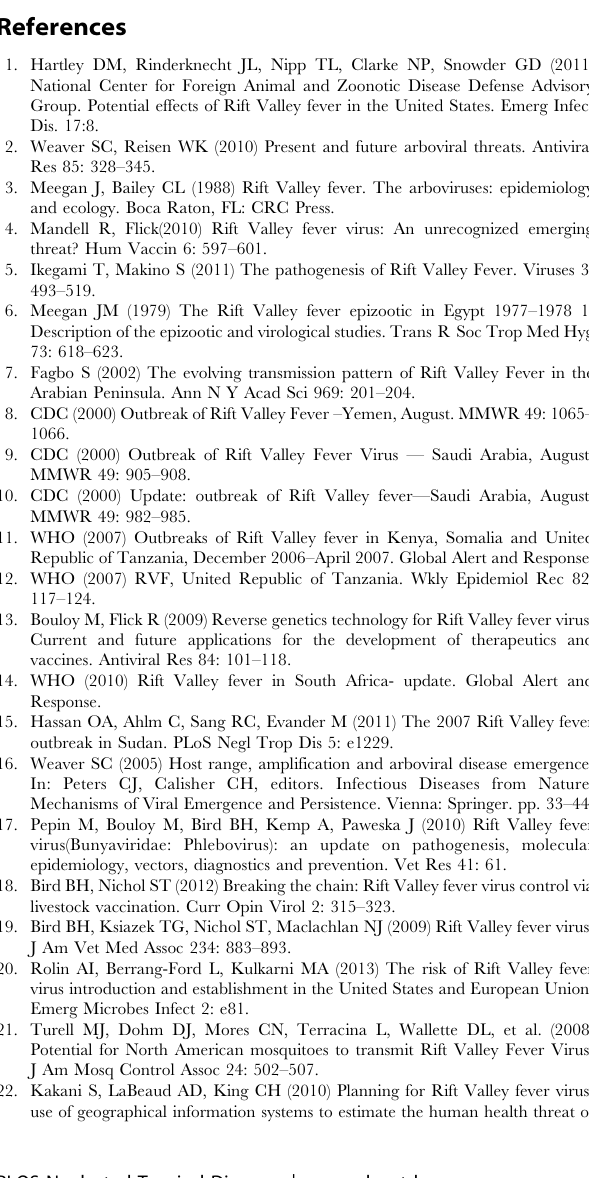
fraction is undetermined at the resolution of Order. Therefore, all order % risk estimates are minimum